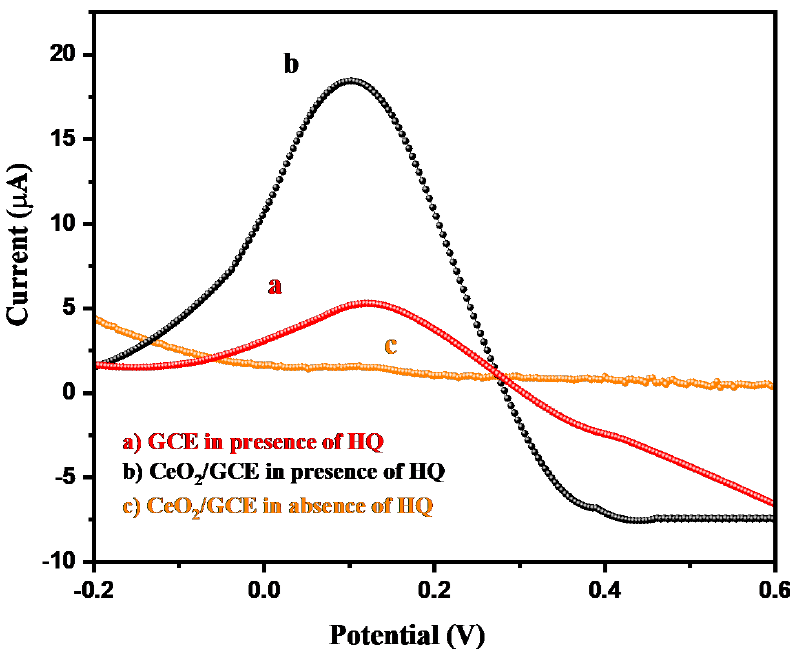
Figure 7. DPV graph of GCE ( a ) and CeO 2 /GCE in presence ( b ) and absence ( c ) of 15 µM HQ in 0.1 M PBS of pH 7.0 (applied scan rate = 50 mV/s).